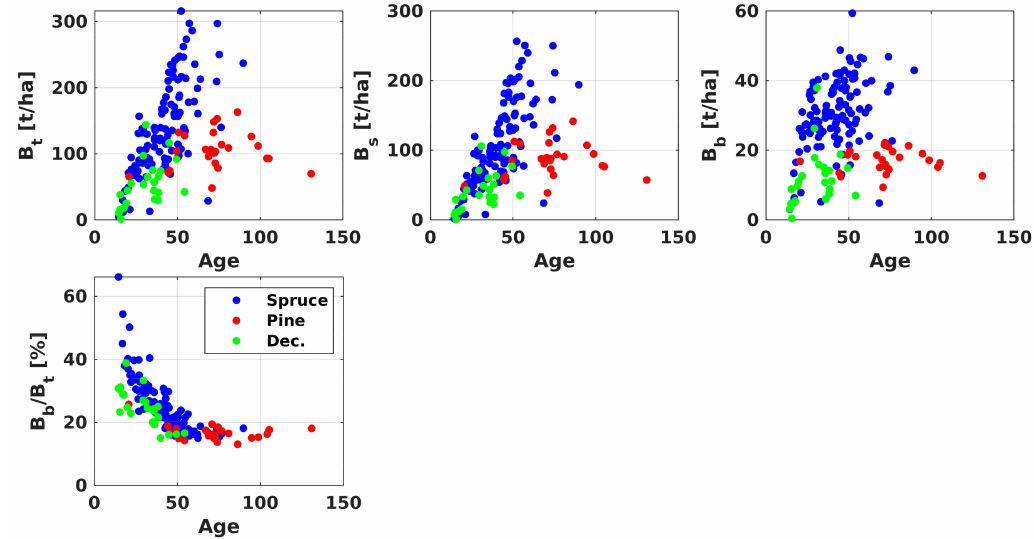
Figure 2. Above-ground (B t , top left ), stem (B s , top center ), and branch biomass (B b , top right ) as functions of forest age. Proportion of above-ground biomass in branches as a function of age ( bottom left